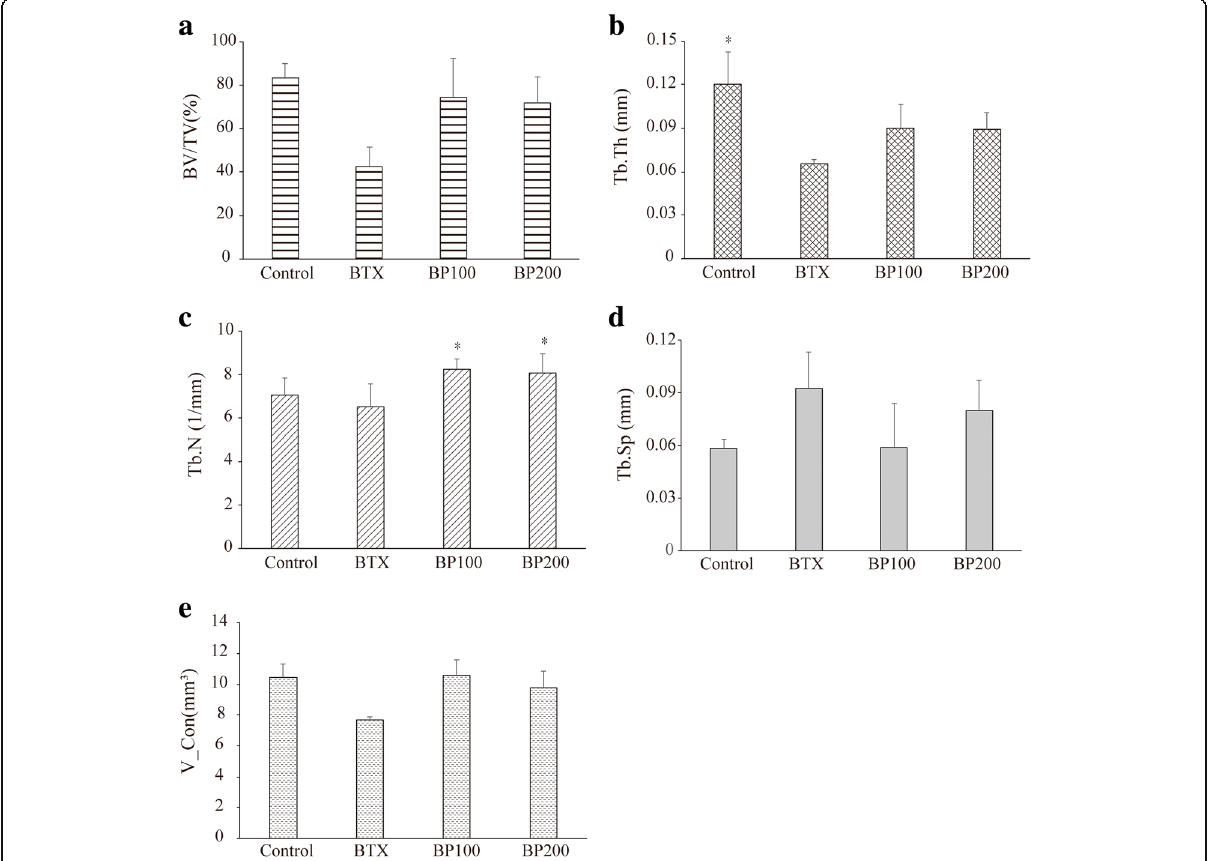
Fig. 4 Microscopic computed tomography ( μ CT) analysis ( a – d ) and three-dimensional analysis of condylar volume ( e ). a Bone volume/tissue volume (BV/TV, %) in the BTX group was the lowest with marginal trend towards significance when compared to the other groups ( p = 0.052). b Trabecular thickness (Tb.Th, mm) was the lowest in the BTX group ( p = 0.025). However, significant difference was observed only between the BTX and control groups. c Trabecular number (Tb.N, 1/mm) was the lowest in BTX. BP100 and BP200 groups showed significant higher value compared with the BTX group. d Trabecular number (Tb.N, 1/mm) and trabecular separation (Tb.Sp, mm) showed no significant difference among the four groups. e Volume of the condyle on three-dimensional analysis showed similar result with BV/TV (%). *Statistically significant difference compared with the BTX group ( p < 0.05)